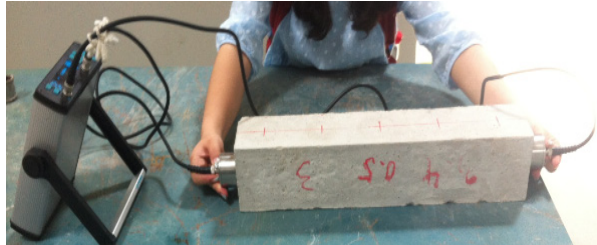
Figure 4. Direct UPV measurement.